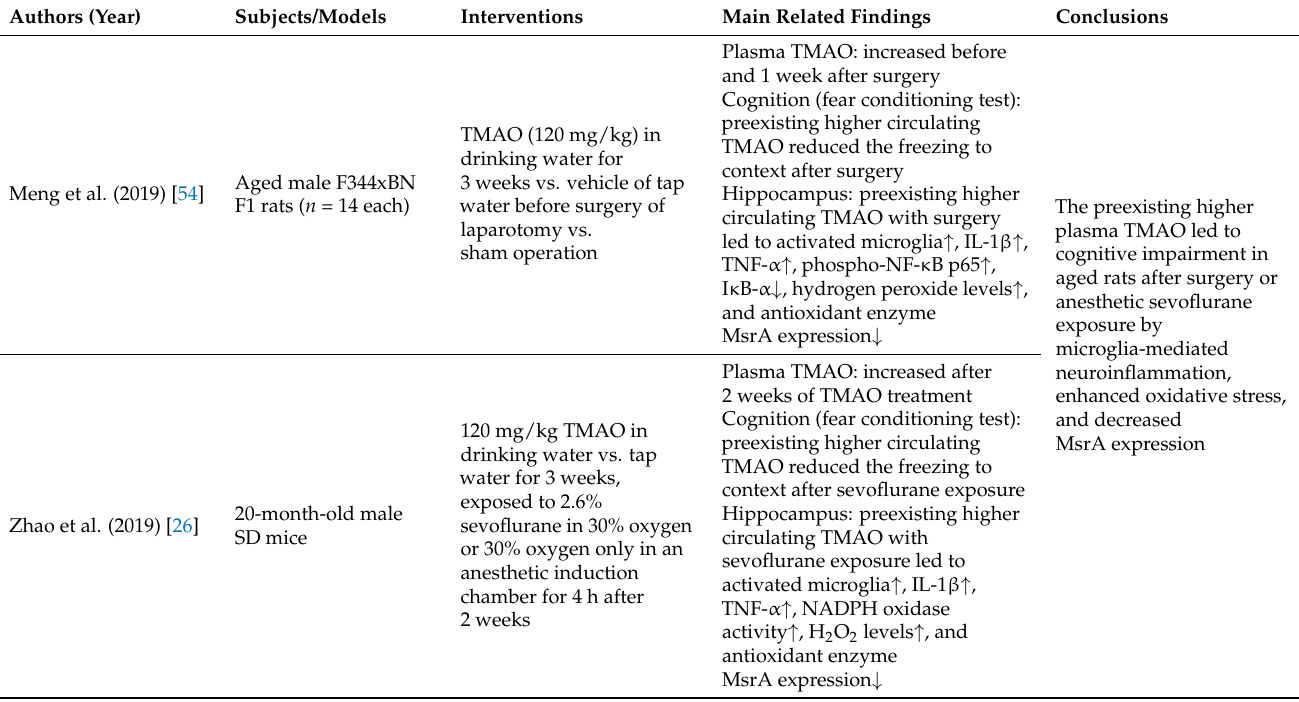
Table 5. Main studies of TMAO involved in postoperative cognitive